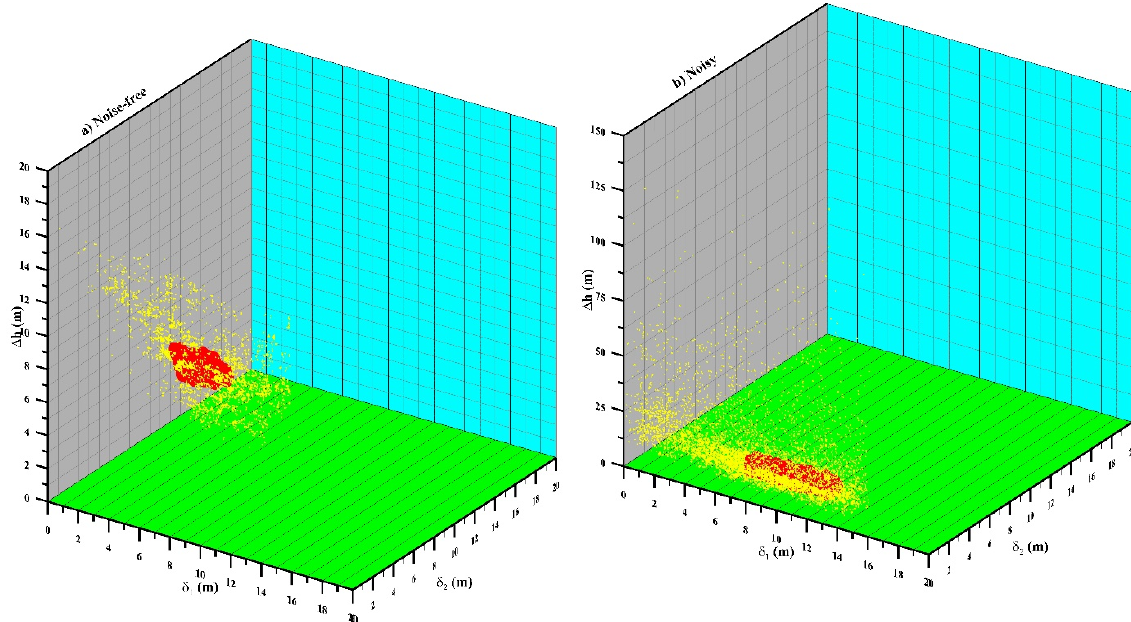
Figure 9. 3D cross-plot for 2D layer/bed Model 1: ( a ) Noise-free, and ( b ) Noisy synthetic data.